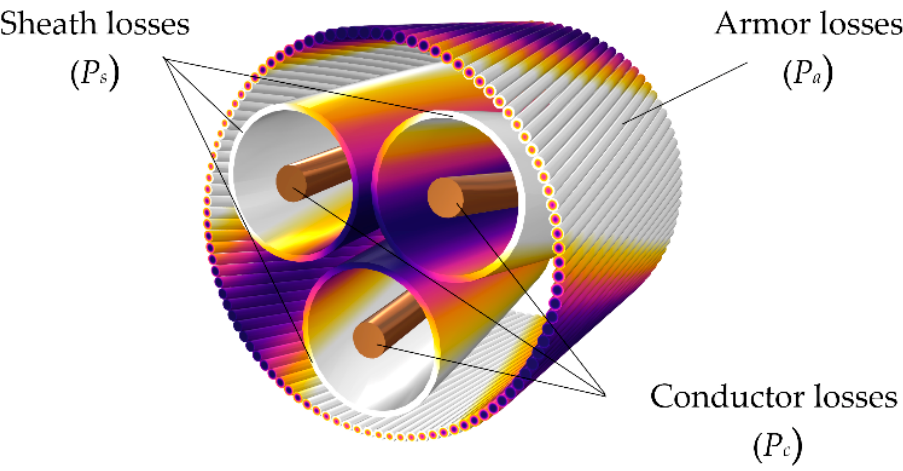
Figure 1. Example of loss color plot (white: high, purple: low) in a three-core armored cable.